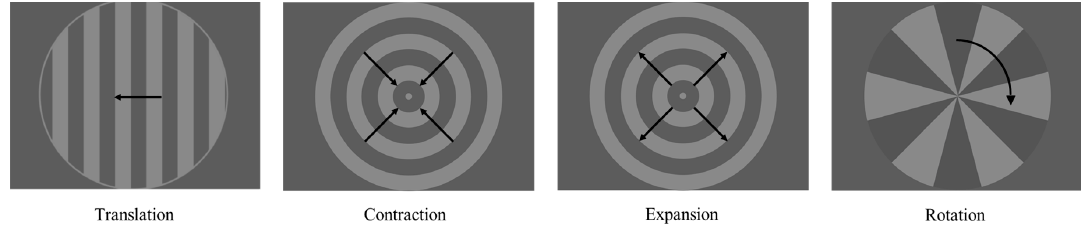
Figure 1. Four types of motion stimuli. The arrows on the figures indicate the direction of movement.